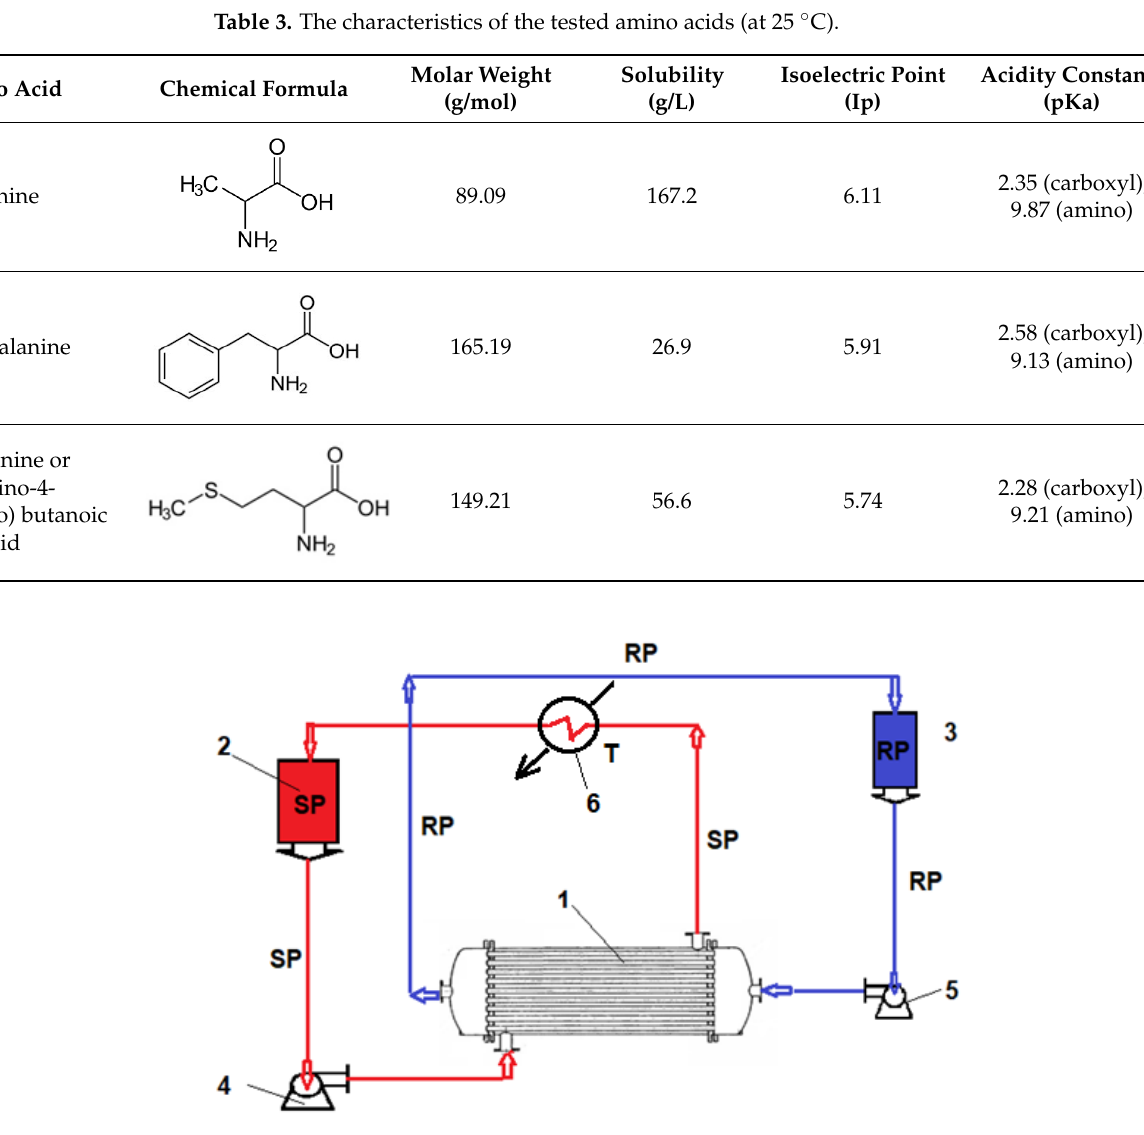
Figure 4. Depiction of the operational scheme with the pertraction module: SP – source phase, RS – receiving phase. 1 . Hollow fiber pertraction module; 2 . SP reservoirs; 3 . RP reservoirs; 4 . SP pump; 5 . RP pump; 6 . T thermostat.